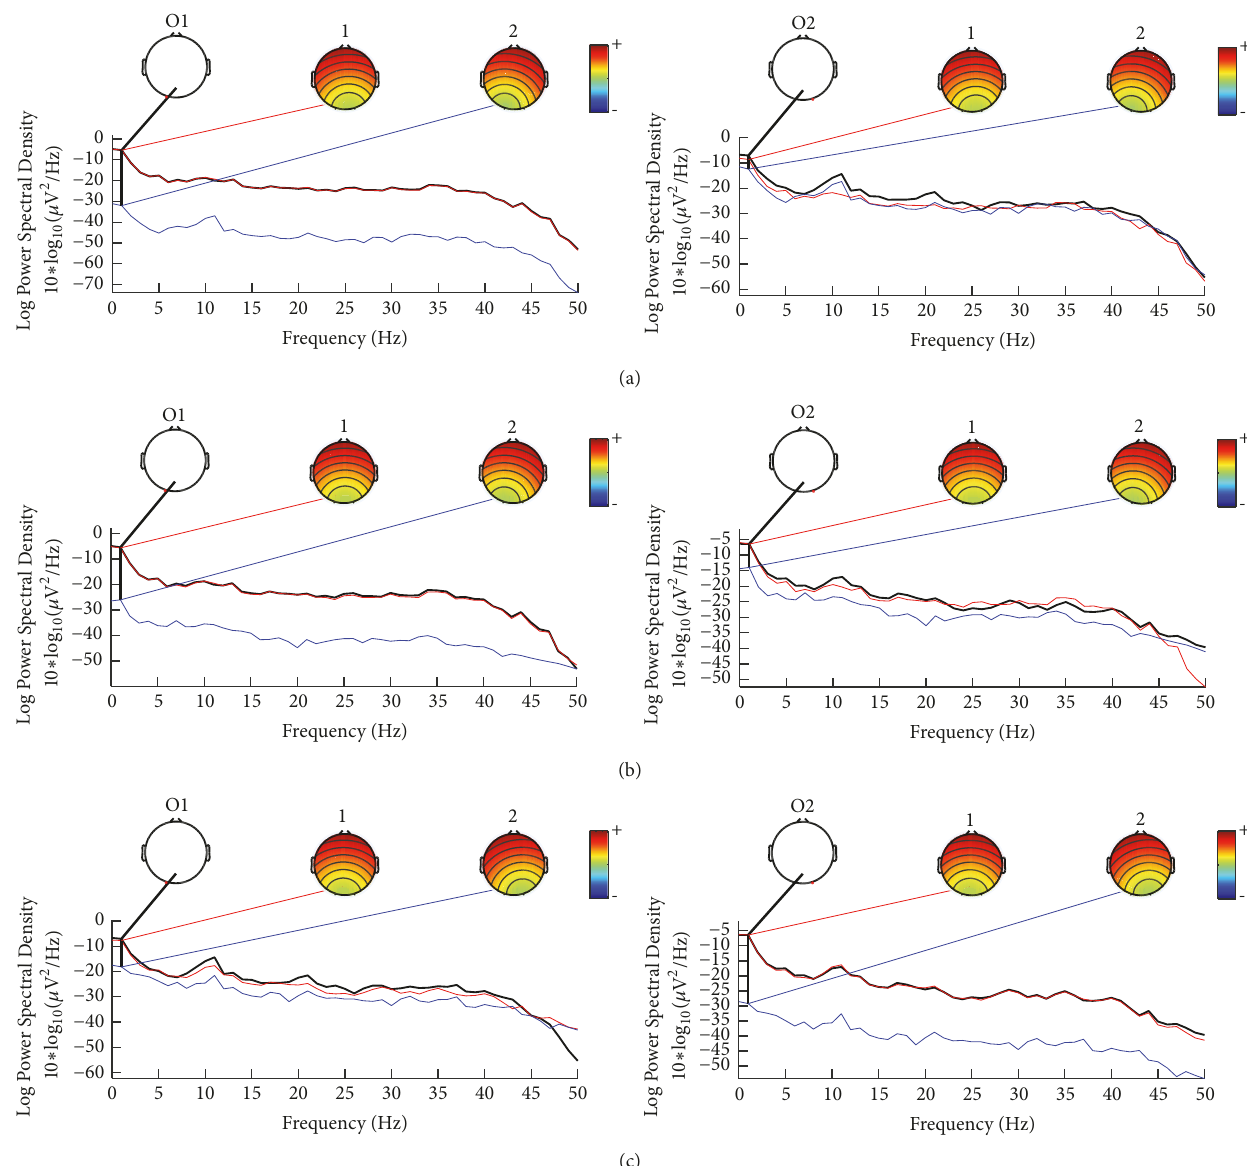
Figure 29: Power spectrum density of channels and ICA components. (a) Mixed O1-O2. (b) Mixed O1-ACO. (c) Mixed O2-ACO. Notes: shown O1 left side, O2 right side.